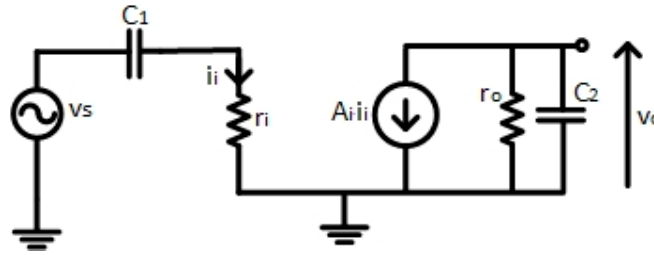
Figure 7. The linear model of the open-loop switched-capacitor integrator.